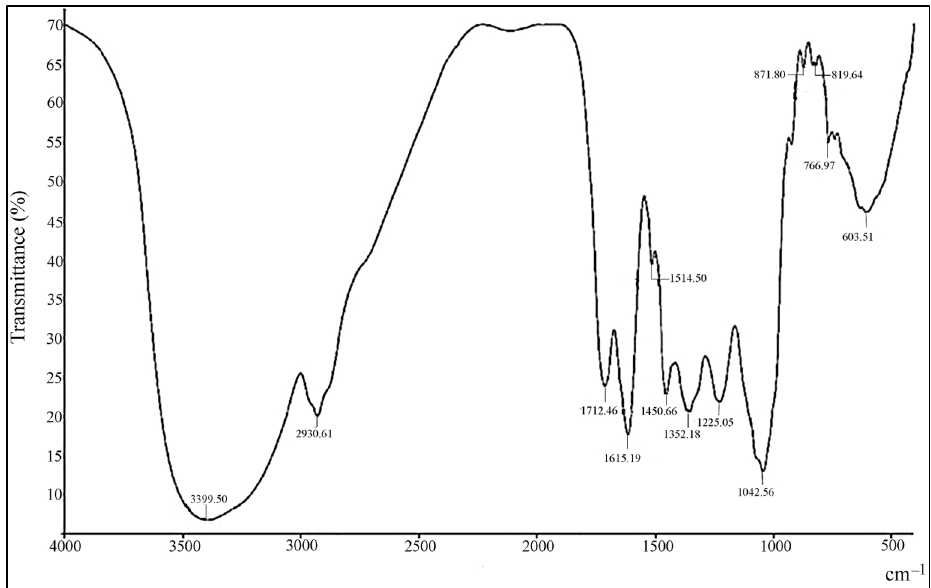
Figure 5. Phytochemical screening by FTIR spectroscopic analysis of P. neglecta EtOAc extract.